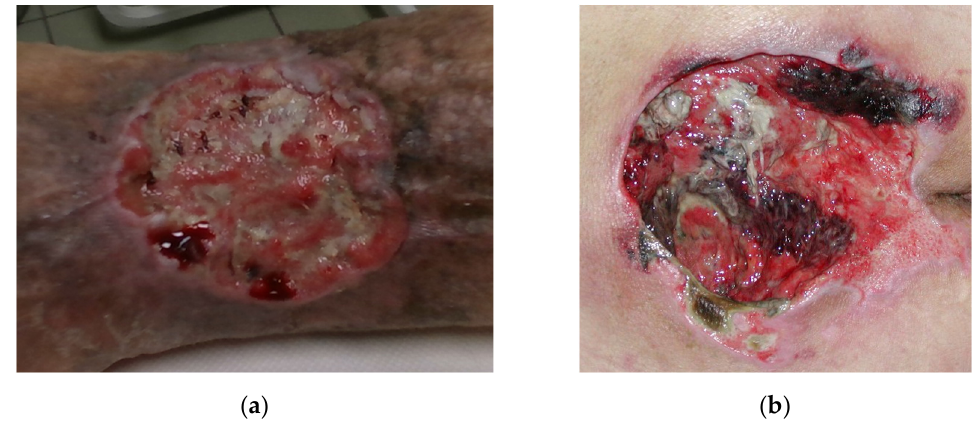
Figure 1. Wound located on: ( a ) leg region; ( b ) lower back region.